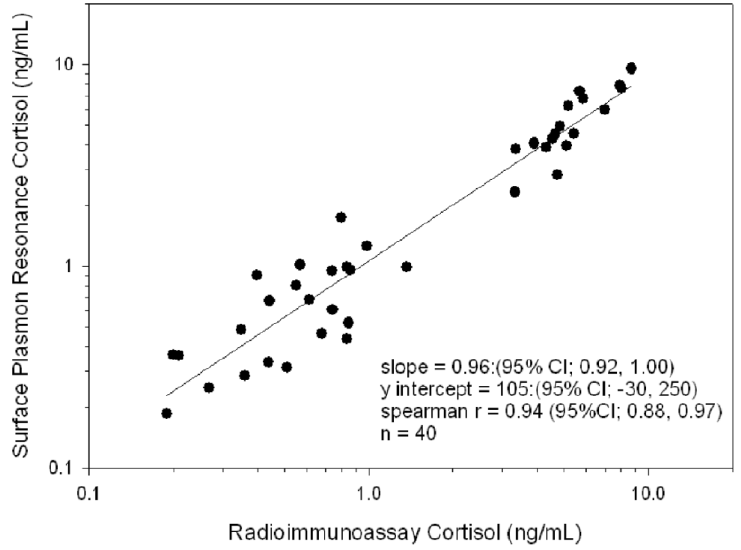
Figure 5. Correlation plot for salivary cortisol samples analyzed by an SPR biosensor and by radioimmunoassay for 40 samples, from reference [33]. Reproduced by permission of The Royal Society of Chemistry